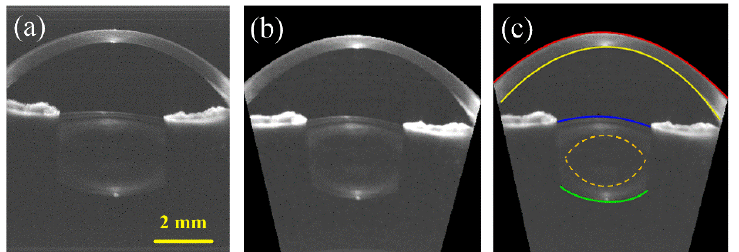
Figure 2. Boundary extraction of lens and nucleus. ( a ) Original image of the anterior segment obtained by SS ‐ OCT. ( b ) Optical refractive correction. ( c ) Contour of the boundaries of the cornea and lens.